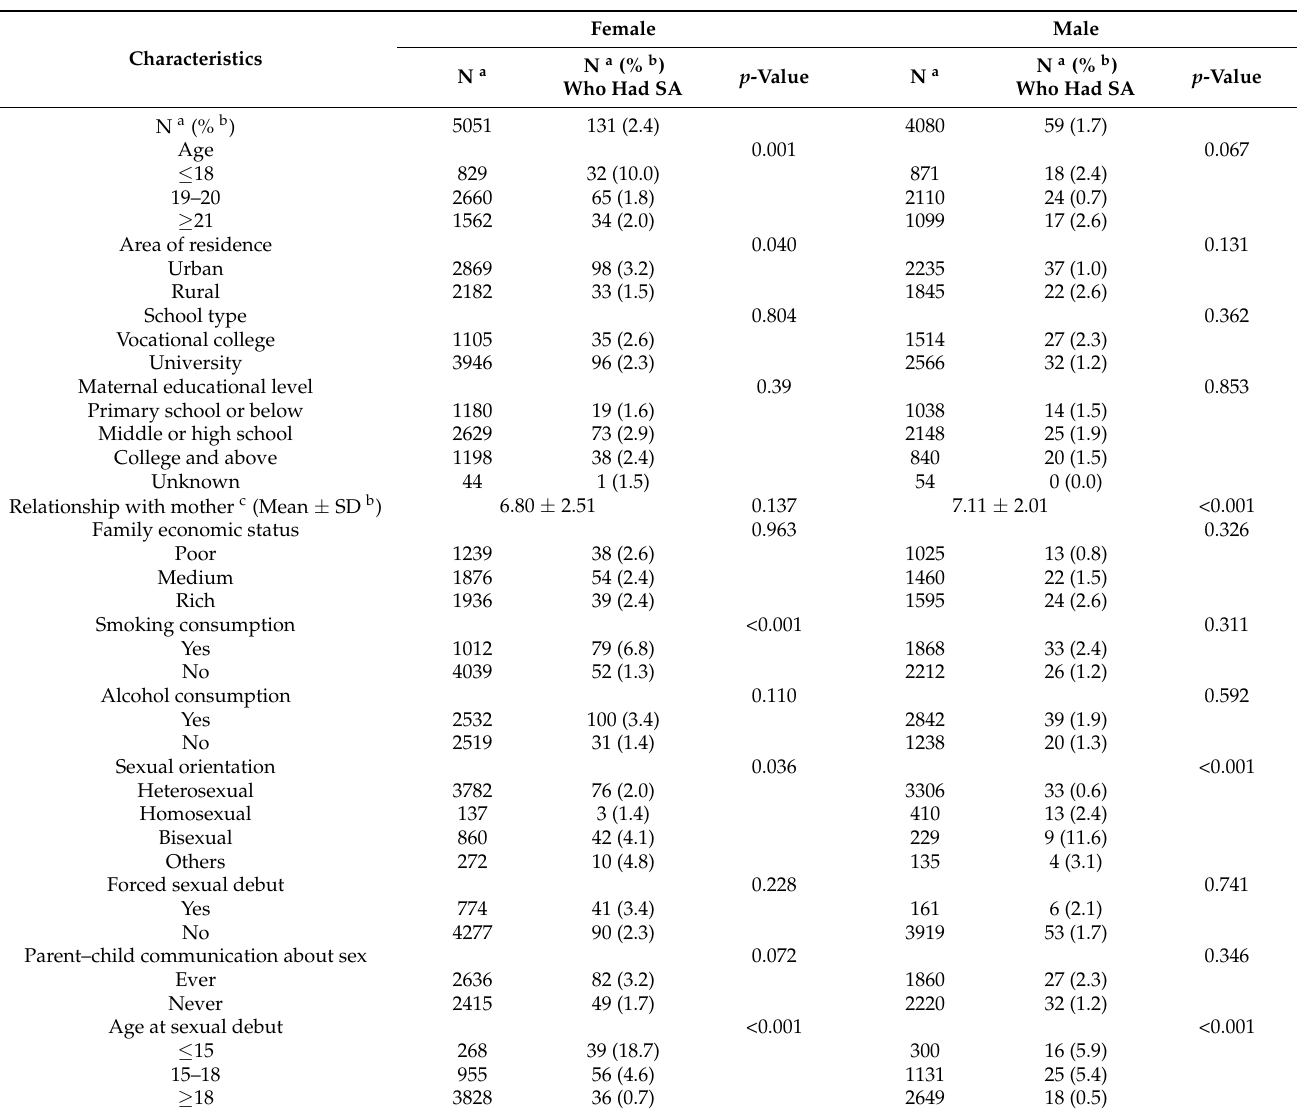
Table 2. Prevalence of SAs by sex (N =